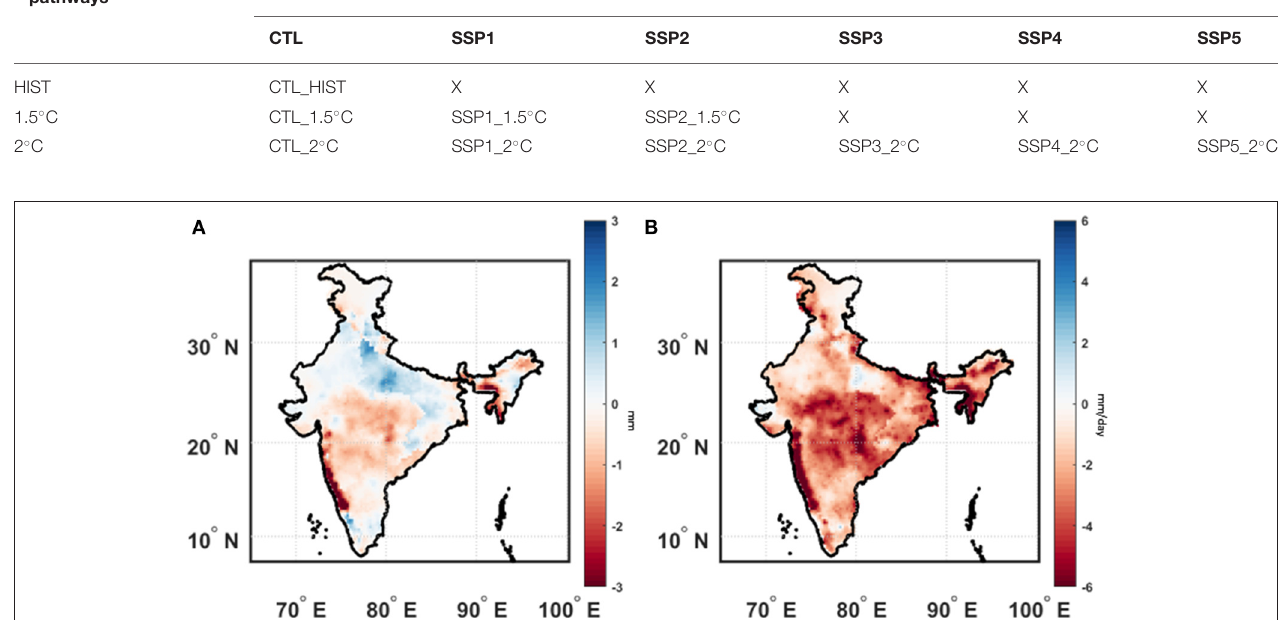
FIGURE 3 | Performance of statistical downscaling model. (A) Difference between mean projected JJAS rainfall and observed JJAS rainfall for validation period (1981–2005) (B) Difference between projected standard deviation of JJAS rainfall and observed standard deviation of JJAS rainfall for validation period (1981–2005).